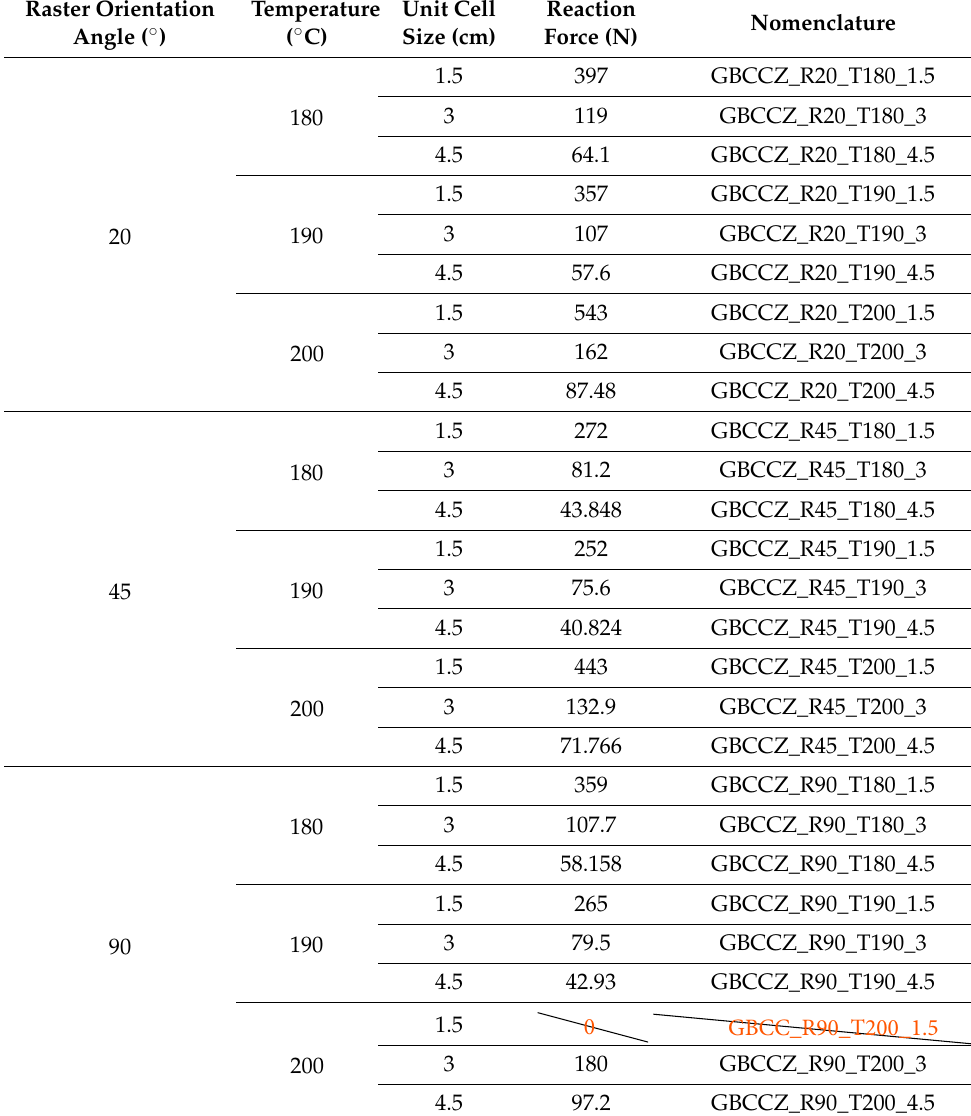
Table A2. Results obtained for BCCz.